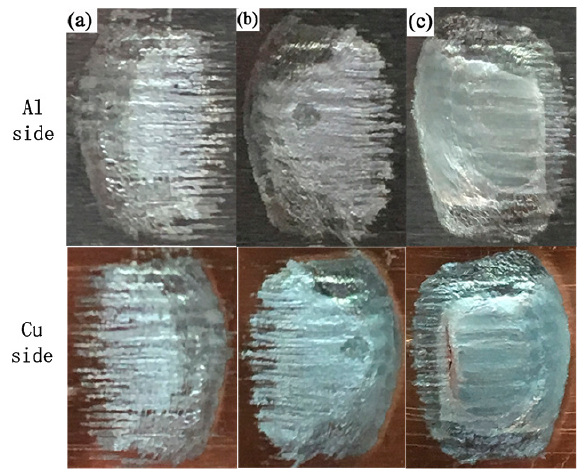
Figure 6. Mechanical performance of ultrasonic welded joints, ( a ) lap shear test results, ( b ) Vickers hardness measured at the amplitude of 25 μ m.